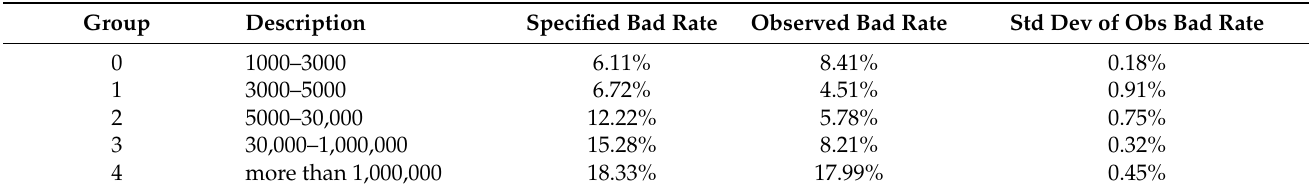
Table A11. Balance of recent